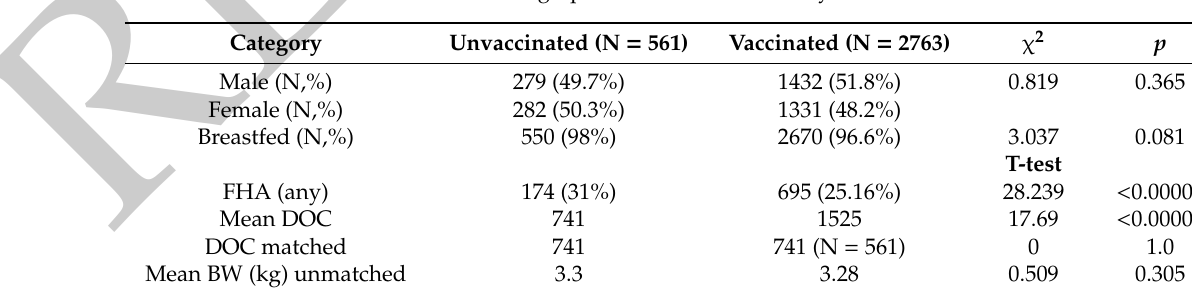
Table 1. Demographic variables in the analyzed data